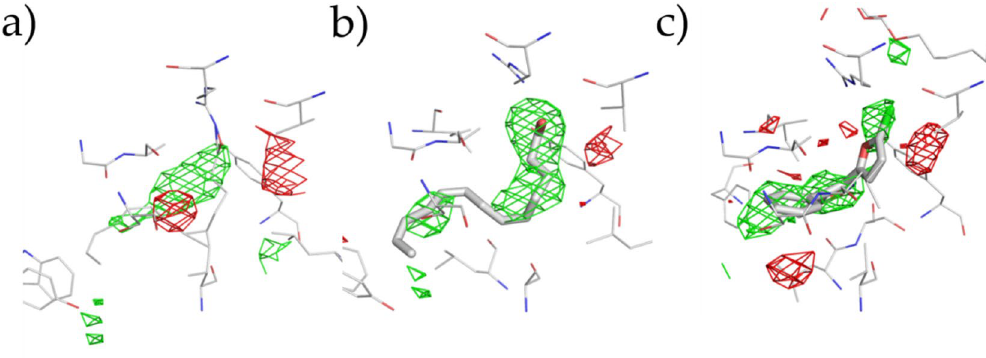
Figure 5. Fourier difference (Fo-Fc) electron density map contoured at >|3σ| (positive and negative peaks are in green and red mesh, respectively) in the substrate site for ( a ), 6Y3C ( h COX-1), ( b ) 1U67 ( o COX-1:AA complex crystal), and ( c ) 5U6X ( o COX-1:P6 complex crystal). Enzymatic protein residues are in gray lines and AA or P6 in the substrate site in gray sticks. Fourier difference electron density map was obtained by removing ligand molecules from the